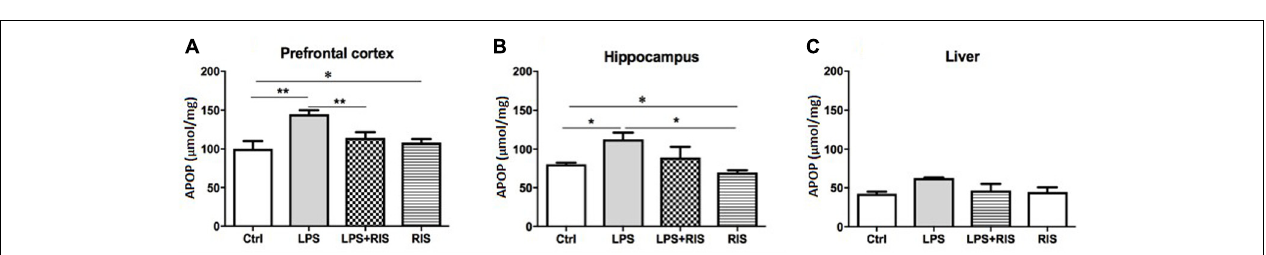
in the LPS ( M = 112.3, SD = 21.44) than control ( M = 80.33, SD = 4.92), LPS + RIS ( M = 89.17, SD = 34.25), and RIS treatment on AOPP in the liver [ F ( 3 , 18 ) = 2.67, p = 0.07]